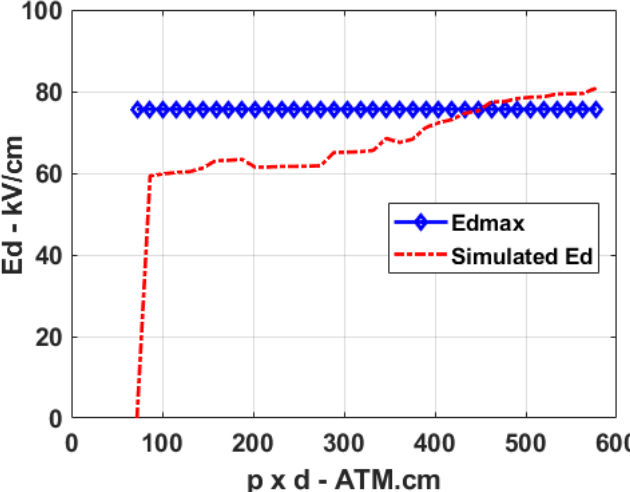
Figure 14. R410A electric field strength during lightning impulse.